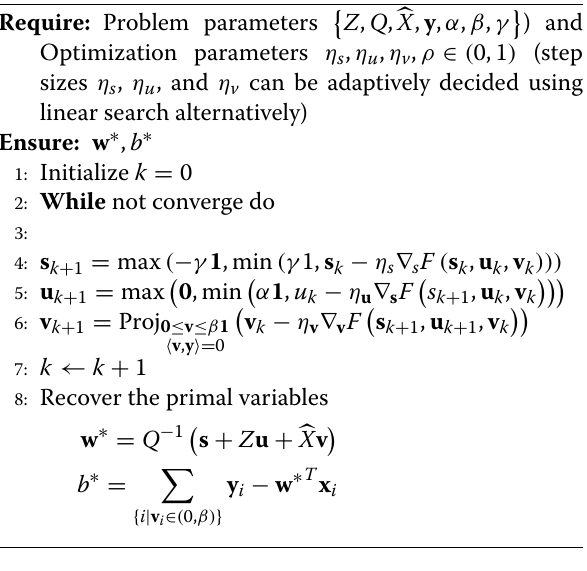
Algorithm 2 Block Coordinate Descent for Solving